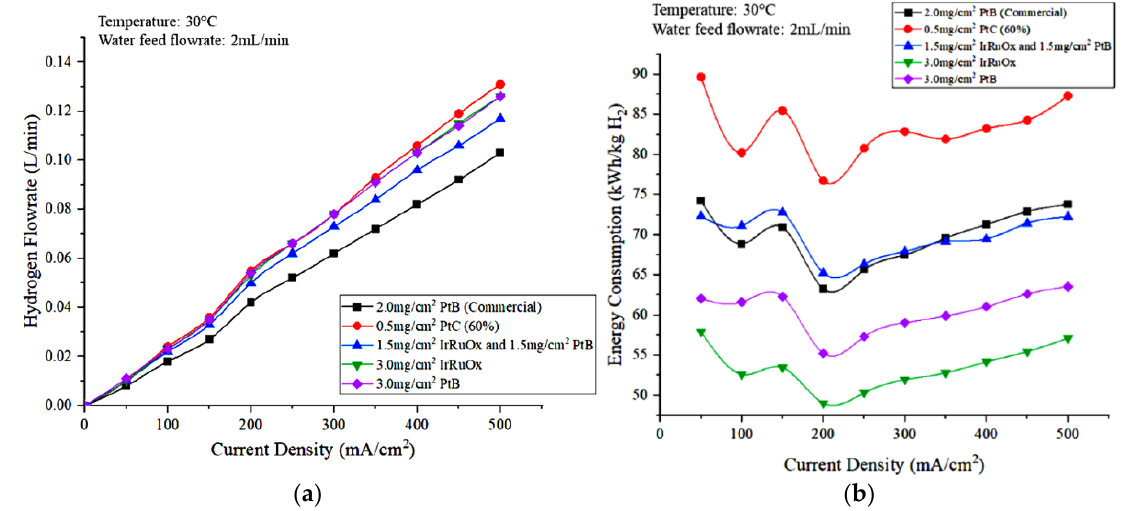
Figure 11. Effects of anode electrocatalyst type and loading on the ( a ) hydrogen production and ( b ) energy consumption of the PEM electrolyzer.